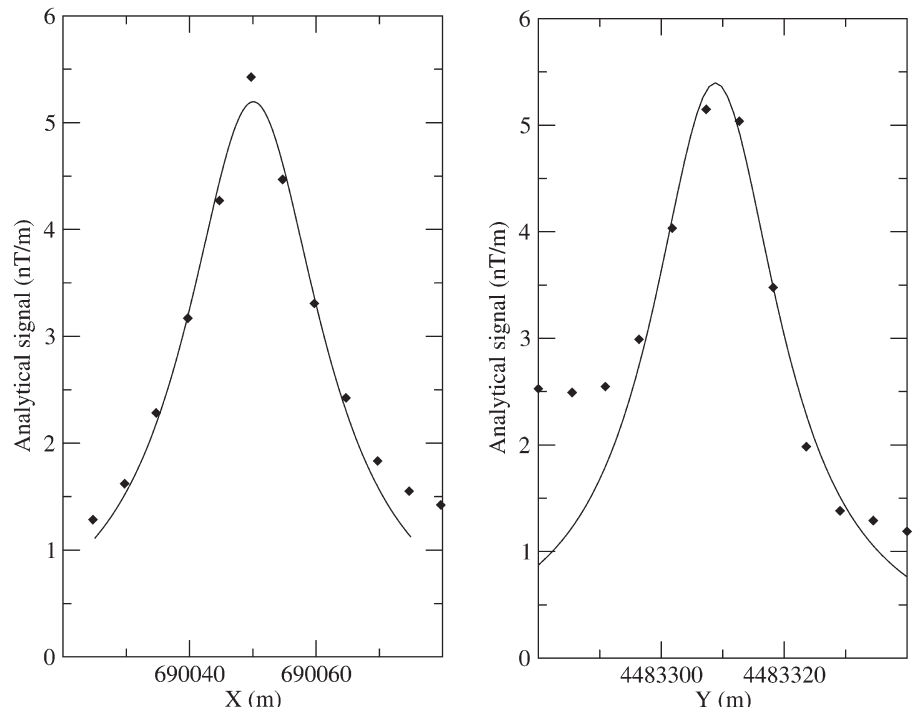
Fig. 7. Analytical signal least squares fit with a bell shaped function in order to estimate the depth of the source of anomaly n.